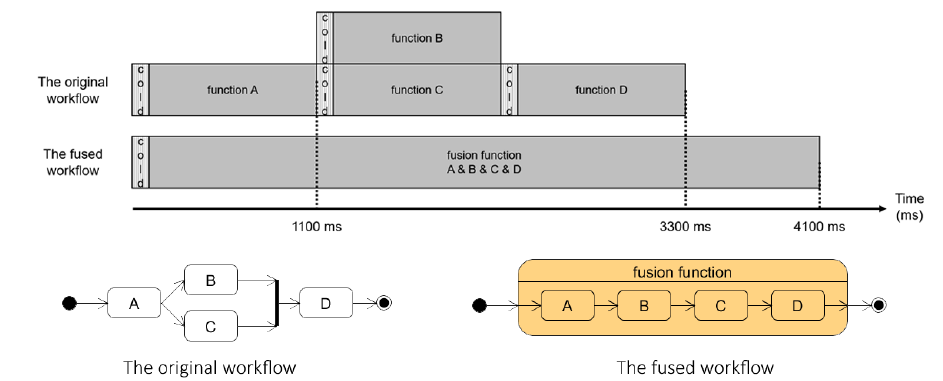
Figure 2. Workflow in this figure has two functions that can be run in parallel. Let the cold start latency be 100 ms and the execution time of functions be 1000 ms. In this case, if all functions in the workflow are fused into a single function, the workflow response time is increased because the functions B and C have to be run in